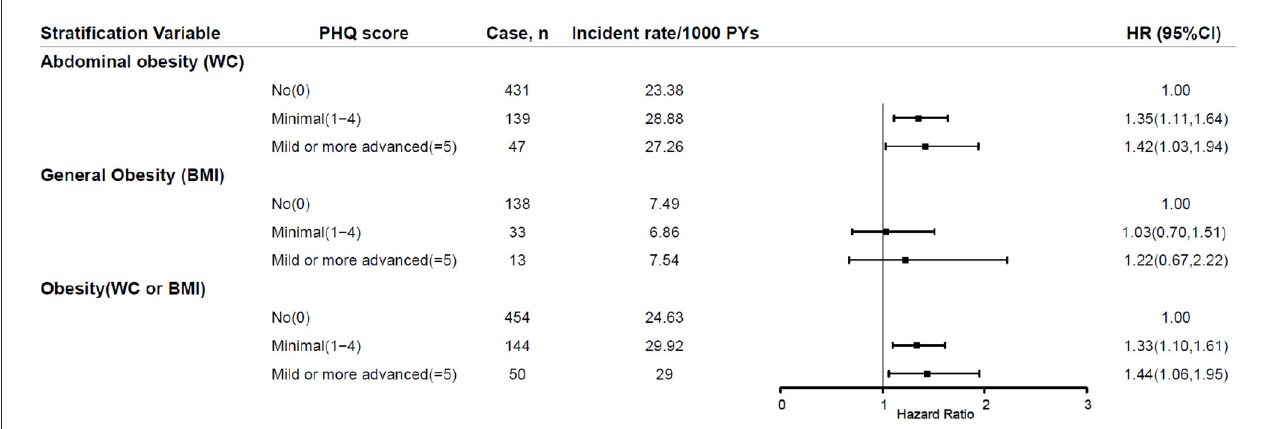
FIGURE3 Sensitivity analyses after exclusion of individuals with overweight at baseline. PHQ-9, Patient Health Questionnaire-9; PY, person years; HR, hazard ratio; BMI, body mass index; WC, waist circumference; 95% CI, 95% confidence